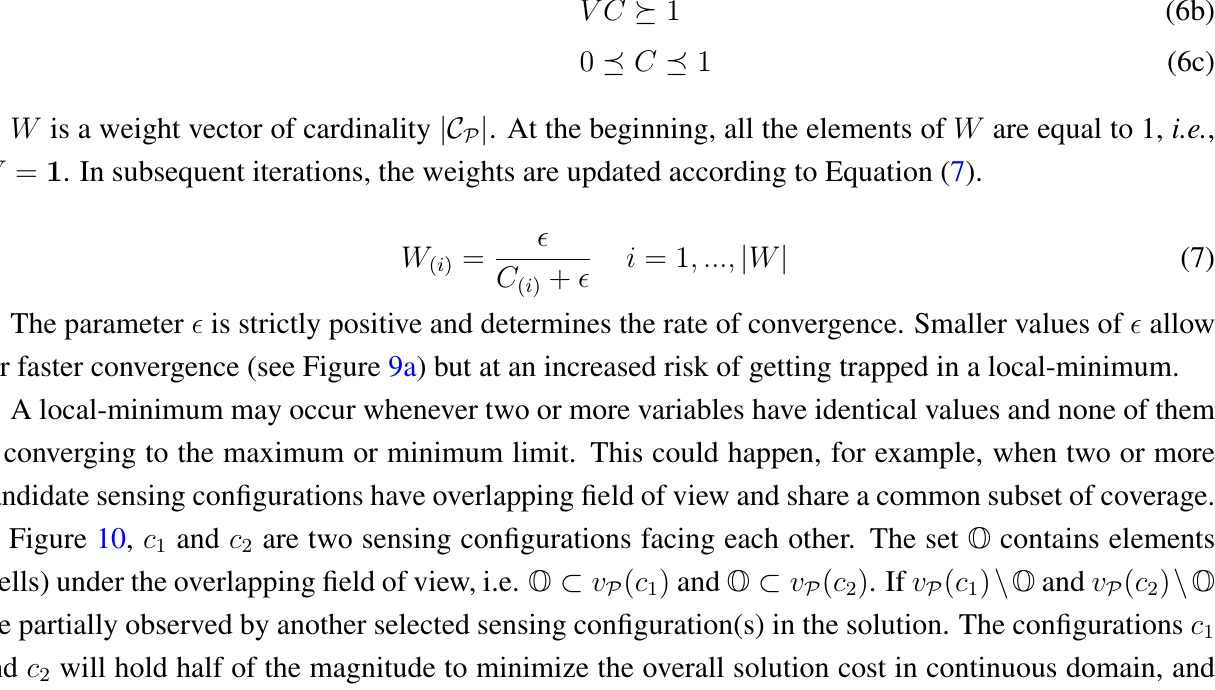
( x ) approximates better the (cid:96) log,(cid:15) ( x ) relaxation f 1 1